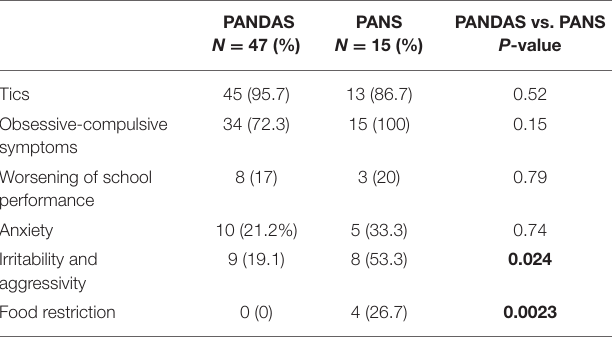
TABLE 4 | Clinical features of PANDAS-PANS relatives.